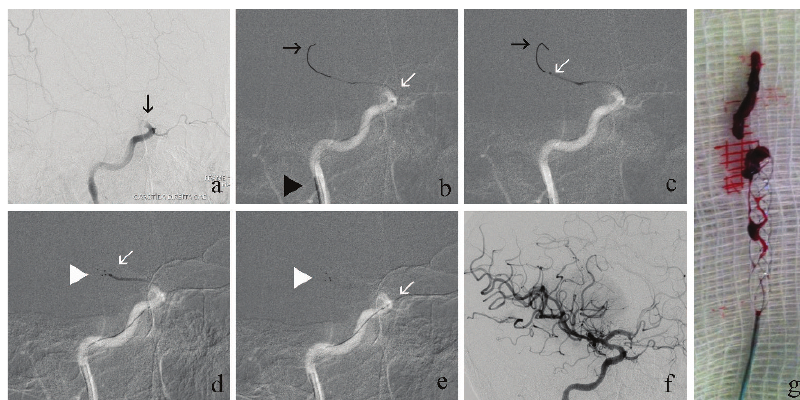
Figure 1 - (a) Digital subtraction angiography (DSA) of the right common carotid artery ([RCCA] arterial phase, oblique view) shows an occlusion of the distal right internal carotid artery (RICA) (black arrow); (b) a road map of the RICA (oblique view) shows a guiding catheter in the RICA (arrowhead); the distal tip of the microcatheter (white arrow) and the microwire have crossed the occluded portion of the RICA and moved through the thrombi and into the right middle cerebral artery (RMCA) (black arrow); (c) a road map of the RICA (oblique view) shows the terminal tip of microcatheter (white arrow) distal to the occlusion site; (d) a road map of the RICA (oblique view) shows the terminal tip of the microcatheter (white arrow) and the terminal radiopaque marks of a 6x30 mm Solitaire AB device (ev3, Irvine, CA, USA), which indicate the start of deployment (white arrowhead); (e) a road map of the RICA (oblique view) in which the proximal stent radiopaque mark is seen ahead of the distal tip of microcatheter (white arrowhead), indicating the full deployment of the stent into the RMCA and the distal RICA; (f) a control DSA of the RCCA (arterial phase, oblique view) that was performed after the stent retrieval shows that the distal RICA, right anterior cerebral artery (RACA) and RMCA branches have been completely opened; (g) a picture shows the Solitaire AB (ev3, Irvine, CA, USA) and the